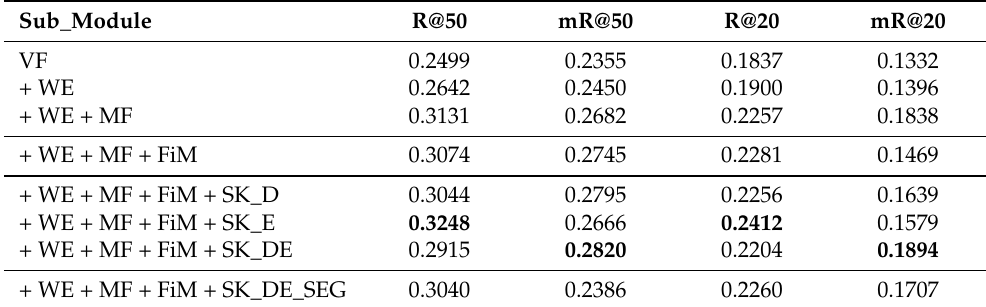
Table 1. Comparison among different combinations of submodules in